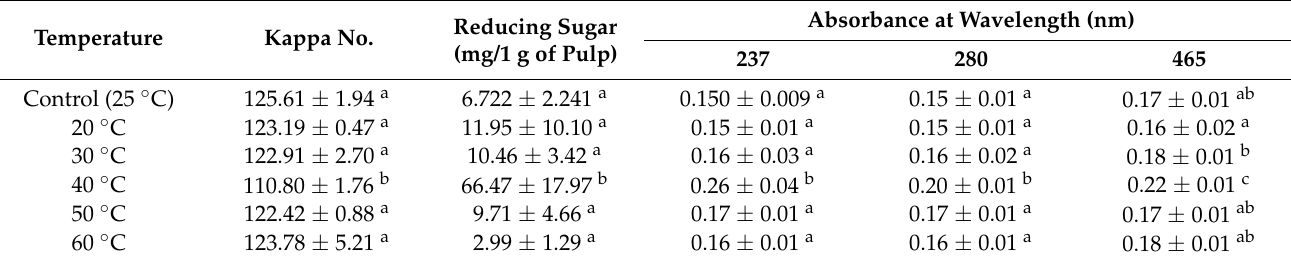
Table 4. Effect of different temperatures on pulp